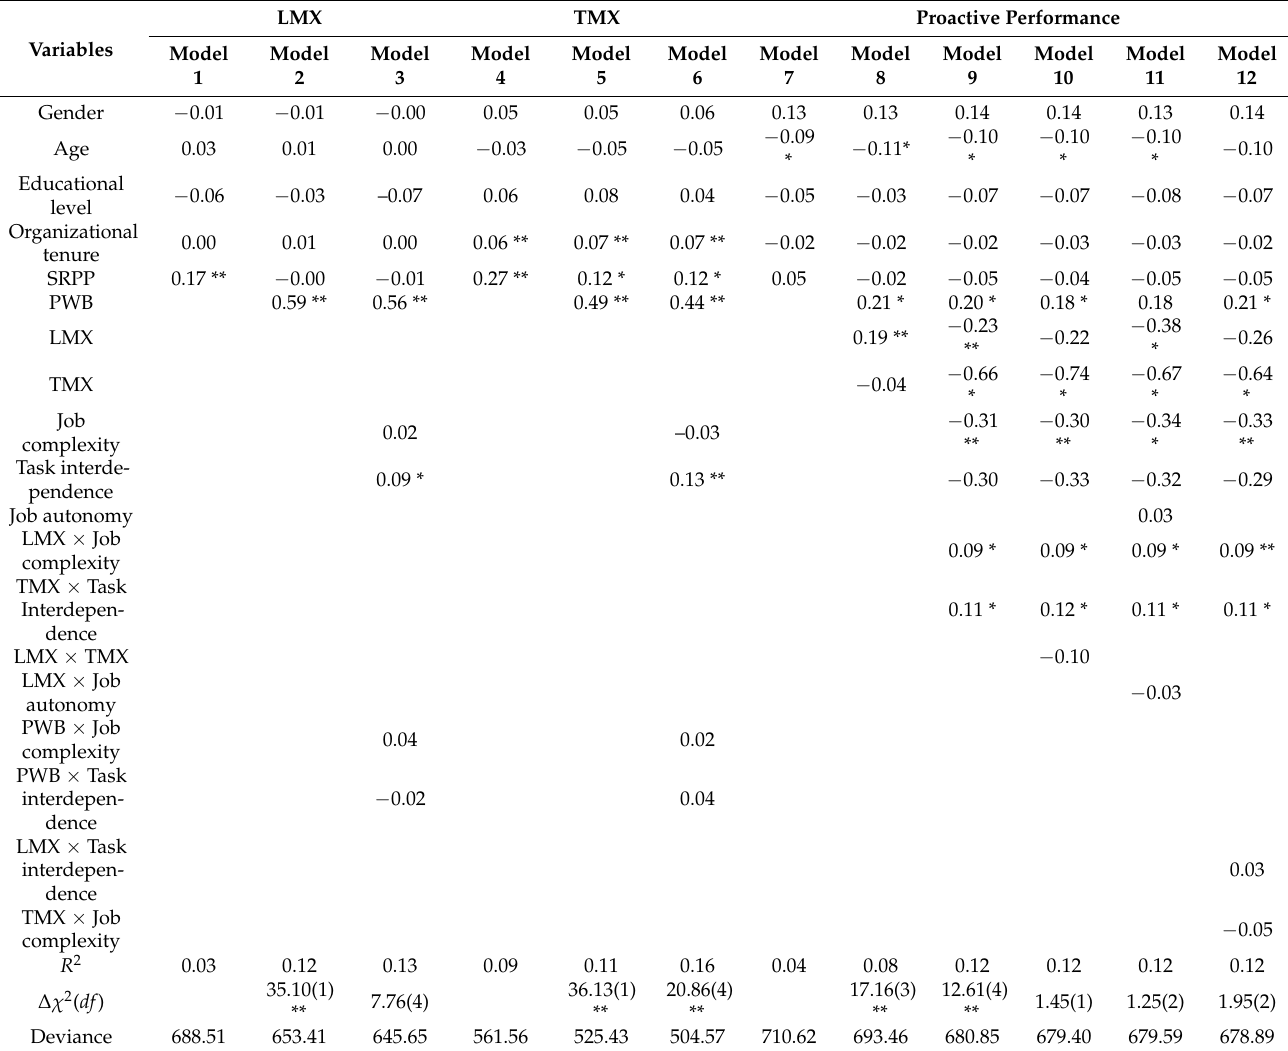
Table 3. Hierarchical Linear Modelling Results for LMX, TMX and Proactive